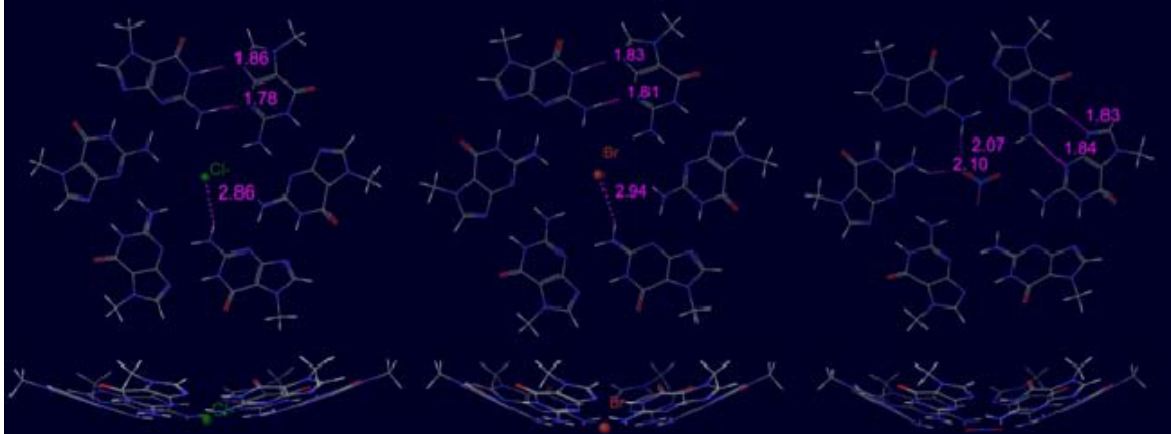
Figure 4. Optimum geometry of m 7 G hexamer with selected (Cl − , Br − , NO without C s